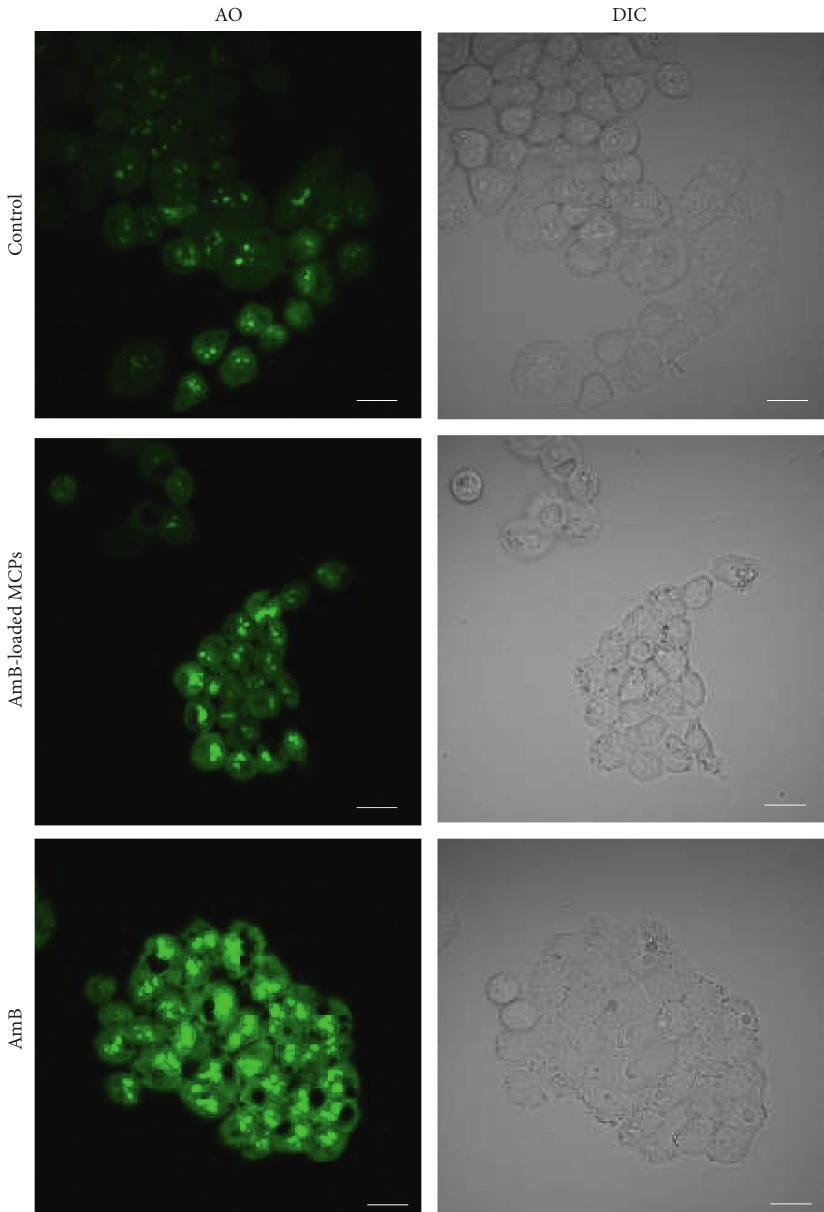
Figure 7: Acridine orange incorporation into lung cells treated with free AmB or AmB-loaded MCPs. Scale bar represents 20 μ